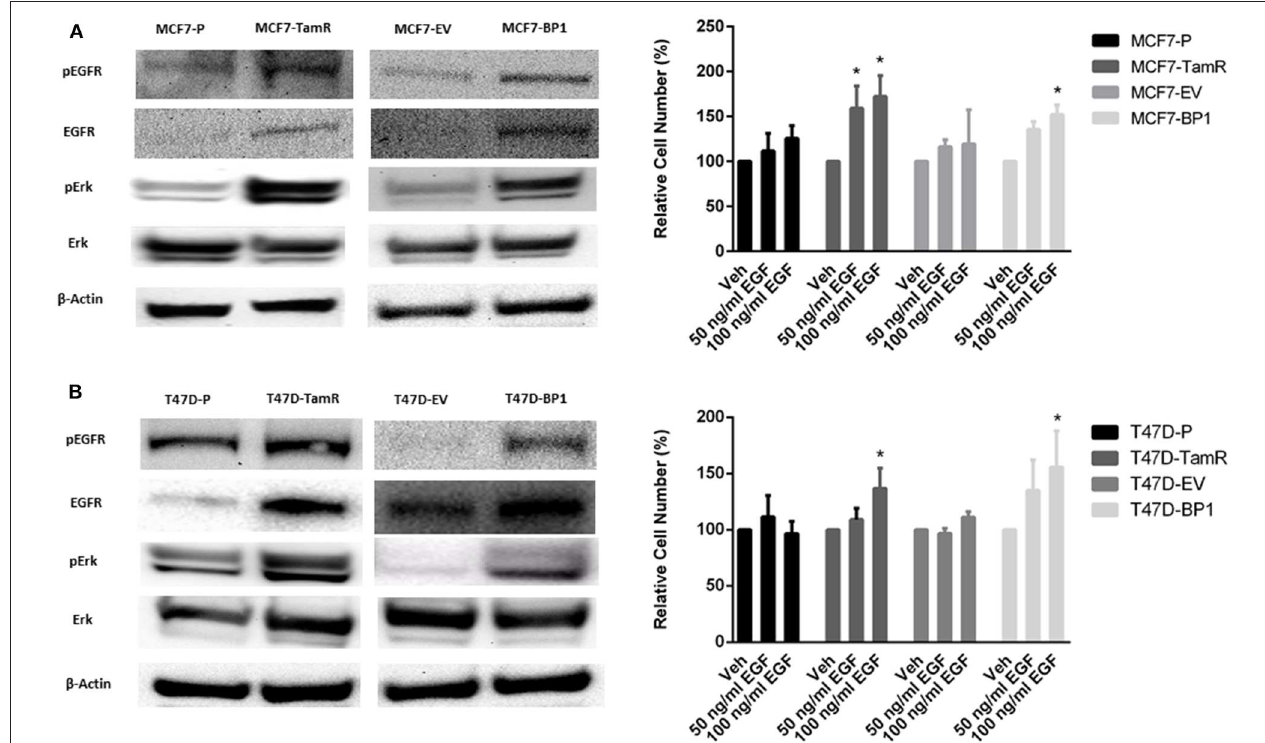
FIGURE 3 | Sustained IGFBP-1 exposure increases EGFR signaling. (A) Immunoblot analysis of phospho-EGFR (Y1068), EGFR, phospho-Erk, and Erk in MCF-7 cells (top); measurement of relative cell number (%) in MCF-7 cells after 5 days of EGF treatment (bottom). (B) Immunoblot analysis of phospho-EGFR (Y1068), EGFR, phospho-Erk, and Erk in T-47D cells (top); measurement of relative cell number (%) in T-47D cells after 5 days of EGF treatment (bottom). Results are the average of 3 independent experiments, and error bars are the standard error of the mean. * p < 0.05.